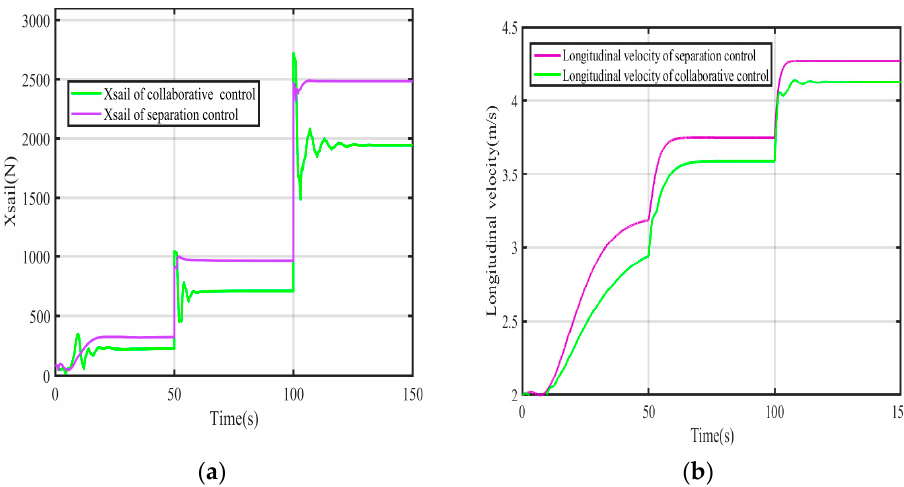
Figure 6. ( a ) Comparison curves of Xsail for sidewind sailing; ( b ) Comparison curves of longitudinal velocity for sidewind sailing.